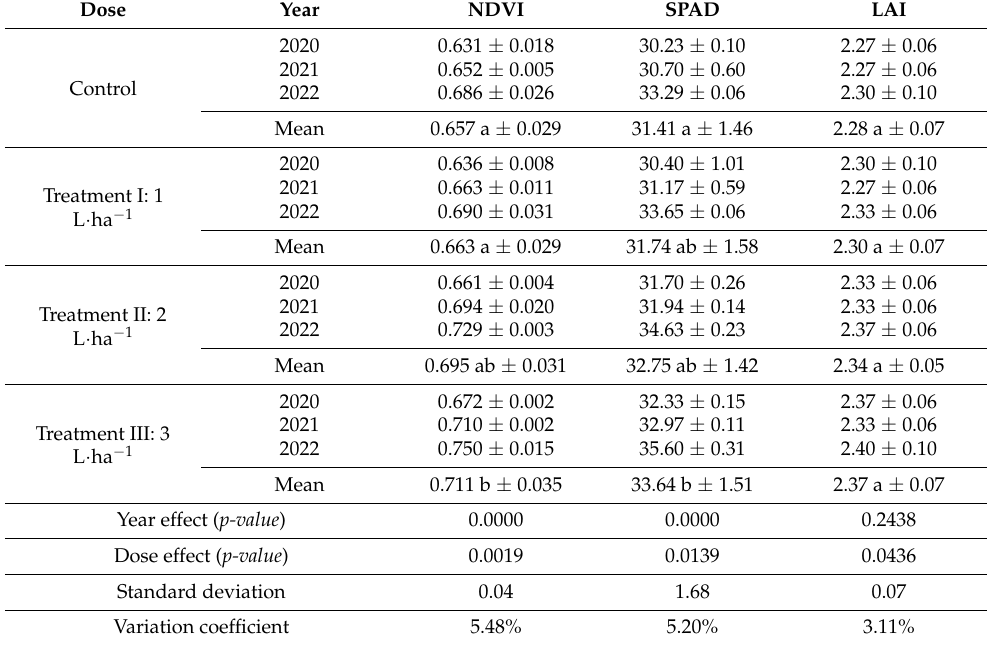
Table 7. Normalized Difference Vegetation Index, Soil Plant Analysis Development and Leaf Area Index, depending on the year and dose of mineral-organic multi-component fertilizer